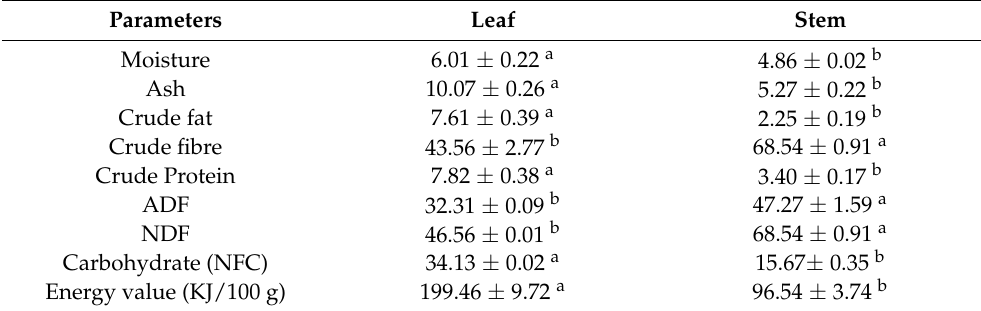
Table 1. Proximate composition of H. odoratissimum leaf and stem (%) of dry weight.